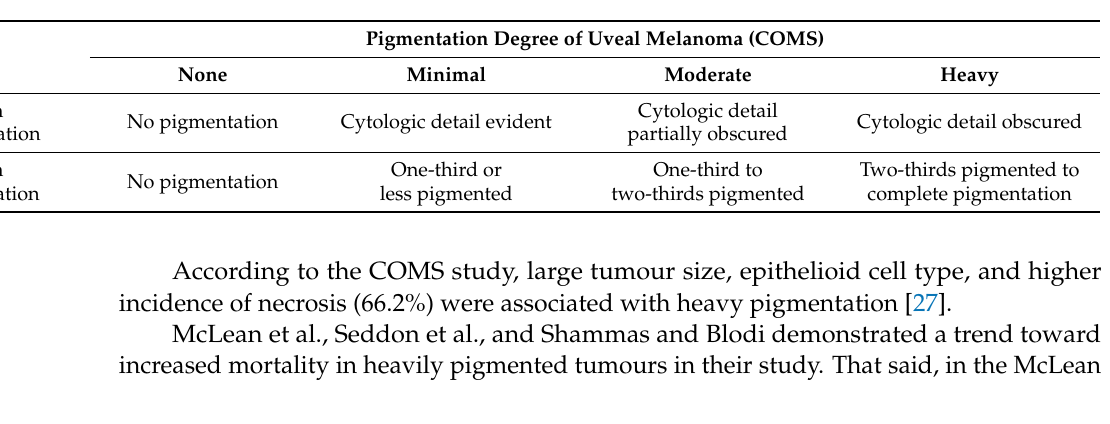
Table 1. COMS classification of uveal melanoma pigmentation based on ref. no 21 and 27